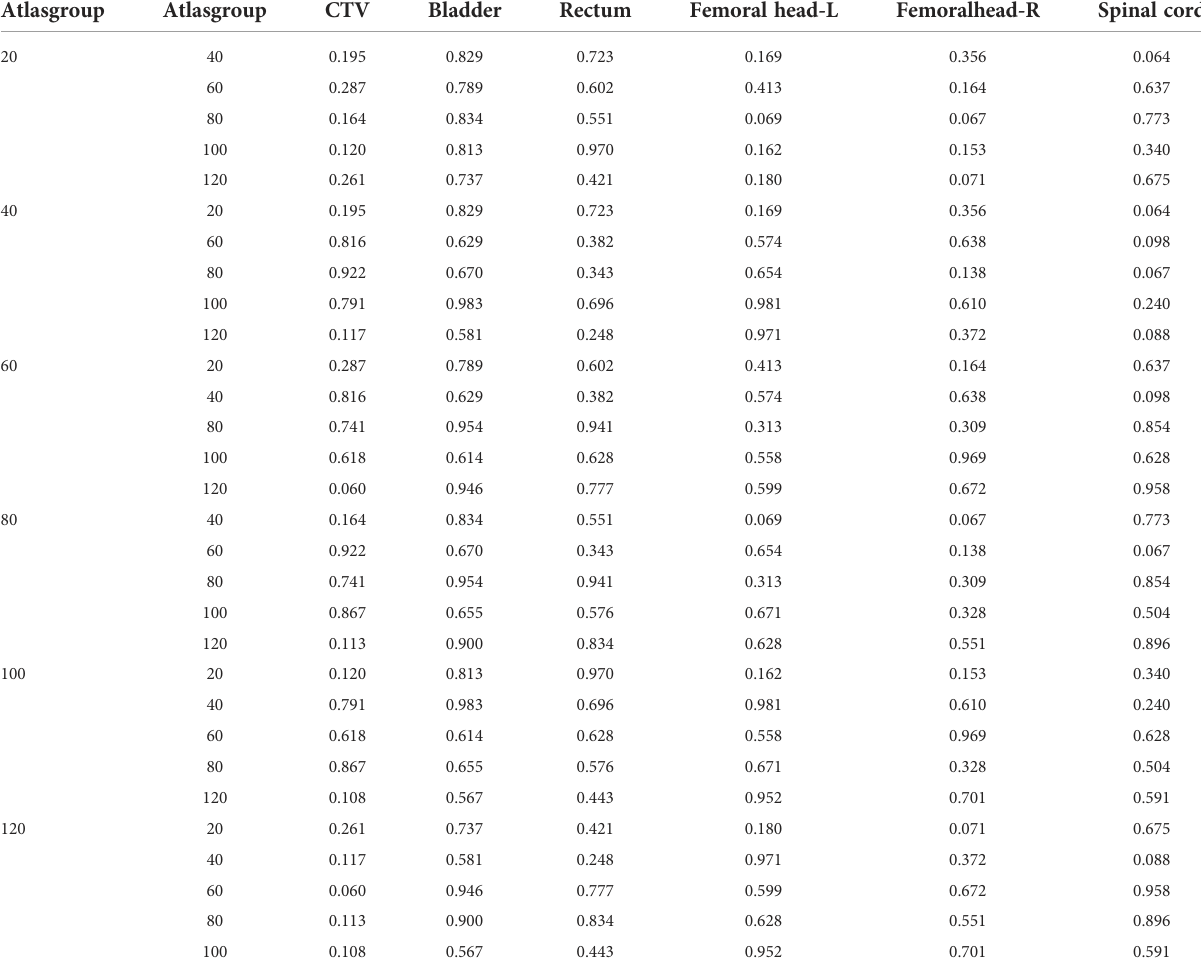
TABLE 6 Results of post-hoc least signi fi cant difference (LSD) with HD value among different atlas library groups. Atlasgroup Atlasgroup